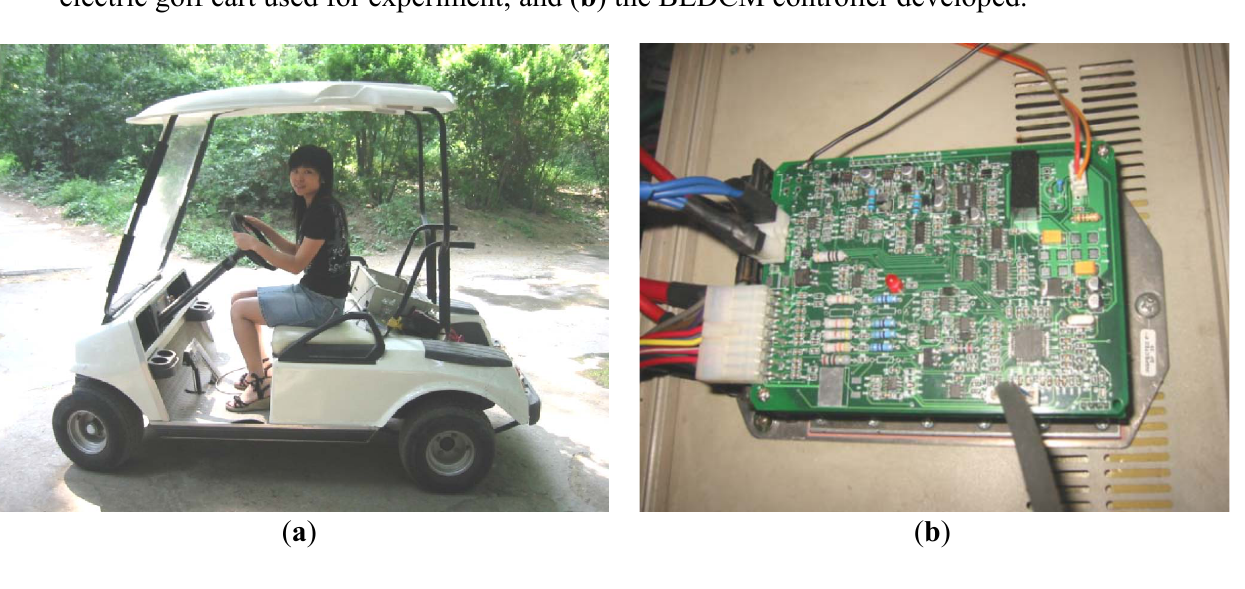
Figure 6. A laboratory experimental prototype and developed controller: ( a ) the laboratory electric golf cart used for experiment; and ( b ) the BLDCM controller